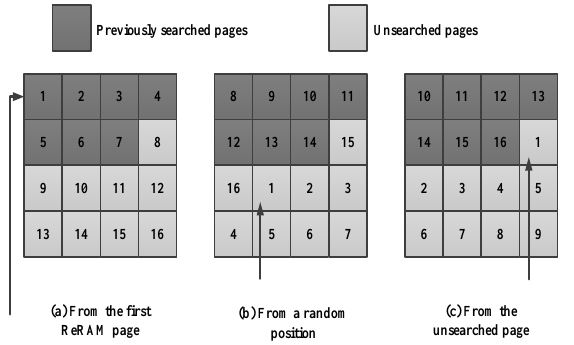
Fig. 8. The approaches for the search of cold page.